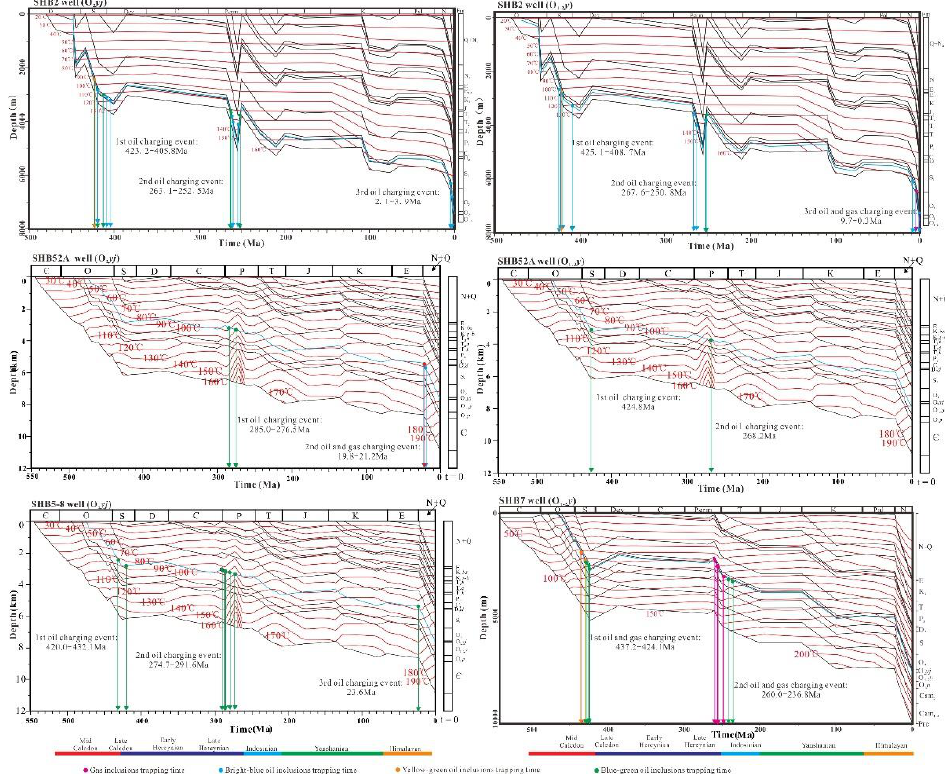
Figure 8. Burial history diagrams showing the hydrocarbon charging history in the Shunbei area.